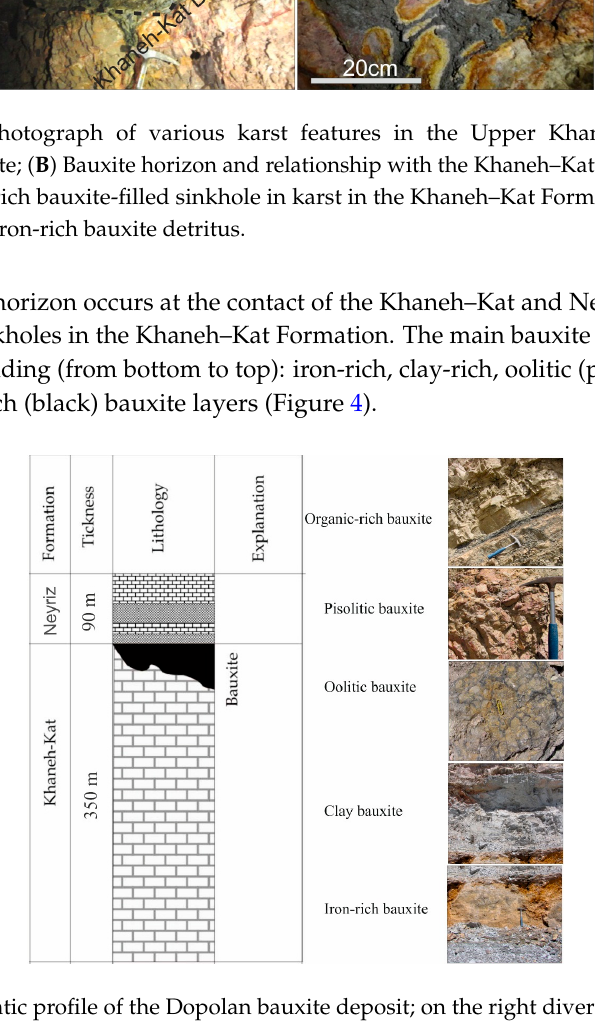
Figure 4. Schematic profile of the Dopolan bauxite deposit; on the right diverse bauxite facies.